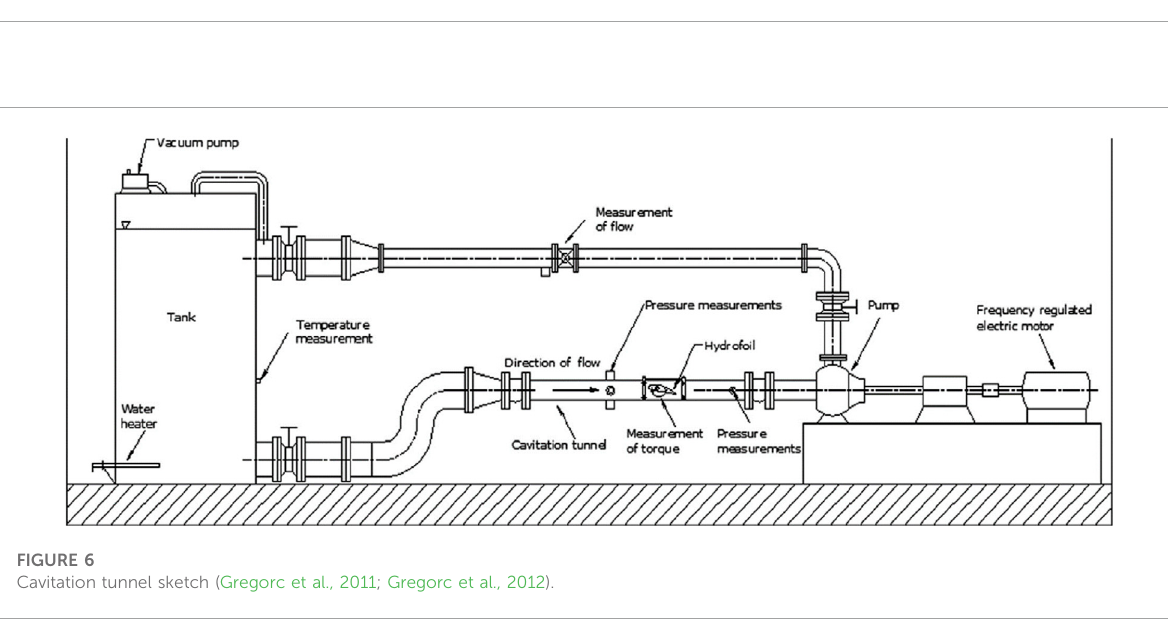
surface was examined by the Wyko MHT-III optical interferometer. The rotating speed was 15,000 r/min for 10 min. Their study showed that particles at a certain size